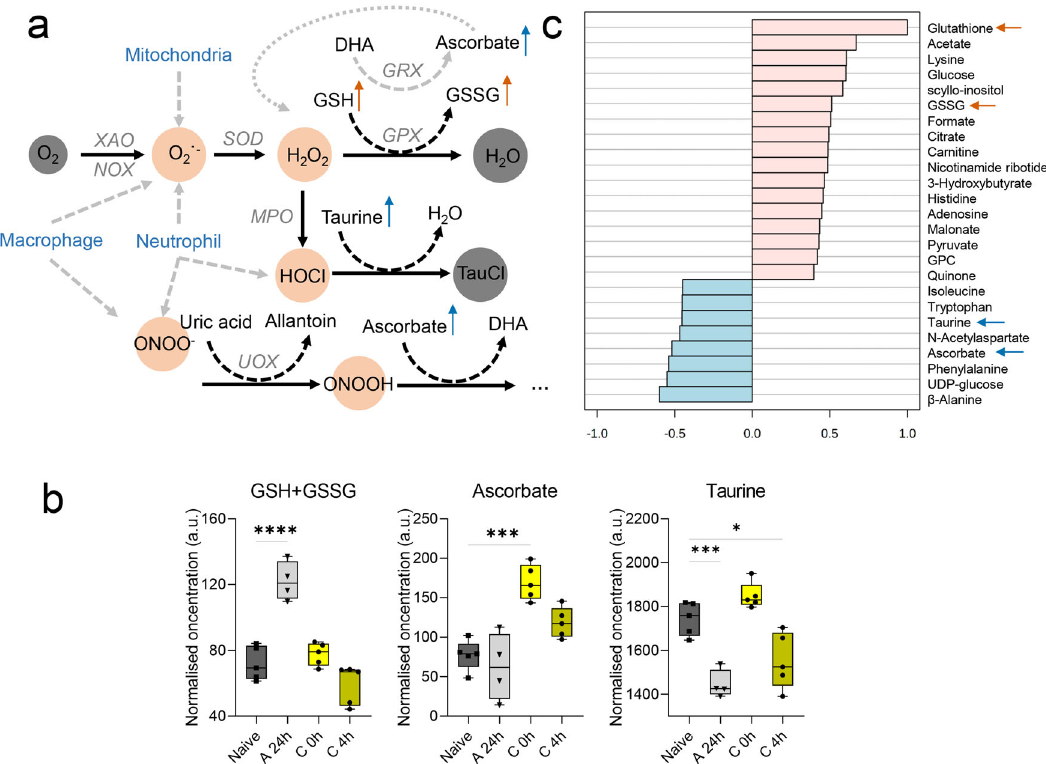
Fig. 5 Redox and immune metabolism during acute and chronic cutaneous DTHR. a Overview of reactive oxygen and nitrogen species (RONS) production by resident and in fi ltrating immune cells during an immune response initiating the RONS cascade and their scavengers. The most important small molecule RONS scavengers, such as glutathione (GSH), ascorbate and taurine, are illustrated at their site of action. The ear swelling response during the acute cutaneous DTHR peak at 24 h is illustrated by the orange arrow, and the chronic cutaneous DTHR peak at 4 h is illustrated by the blue arrow. b Normalised concentration changes illustrated as box plots with max. to min. whisker, individual replicate points and median of GSH and glutathione disul fi de (GSSG) concentration sum, ascorbate and taurine changes during acute 24 h (grey, downward triangle) and chronic 0 h (bright yellow, dot) and 4 h (dark yellow, dot) cutaneous DTHR (compared to naive control (grey, square), P values ****<0.0001, ***<0.001, **<0.01, *<0.05, one-way ANOVA). c Correlation pattern hunter graph of the top 25 most signi fi cantly correlated metabolites to glutathione (GSH) concentration changes over time, based on Pearson r distance measure ( n = 5 animals, except A 24 h n = 4 animals). DHA dehydroascorbate, GPC sn-glycero-3-phosphocholine, GPX glutathione peroxidase, GRX glutaredoxin, GSSG glutathione disul fi de, MPO myeloperoxidase, NADPH reduced nicotinamide adenine dinucleotide phosphate, NOX NADPH oxidase, SOD superoxide dismutase, TauCl taurine chloramine, UDP uridine diphosphate, UOX urate oxidase, XAO xanthine